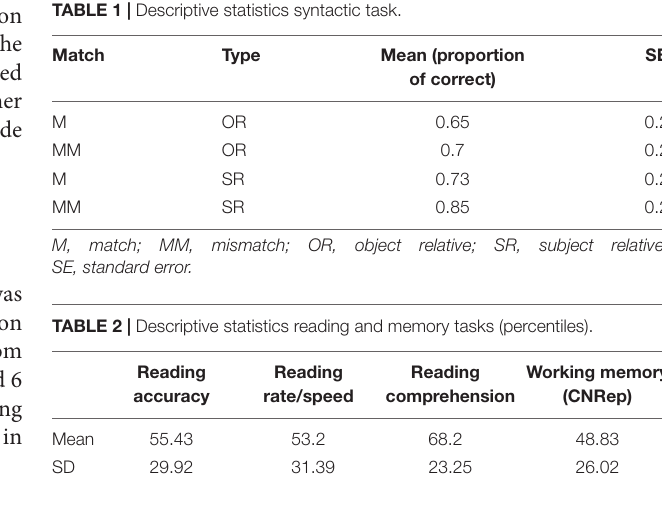
TABLE 1 | Descriptive statistics syntactic task.